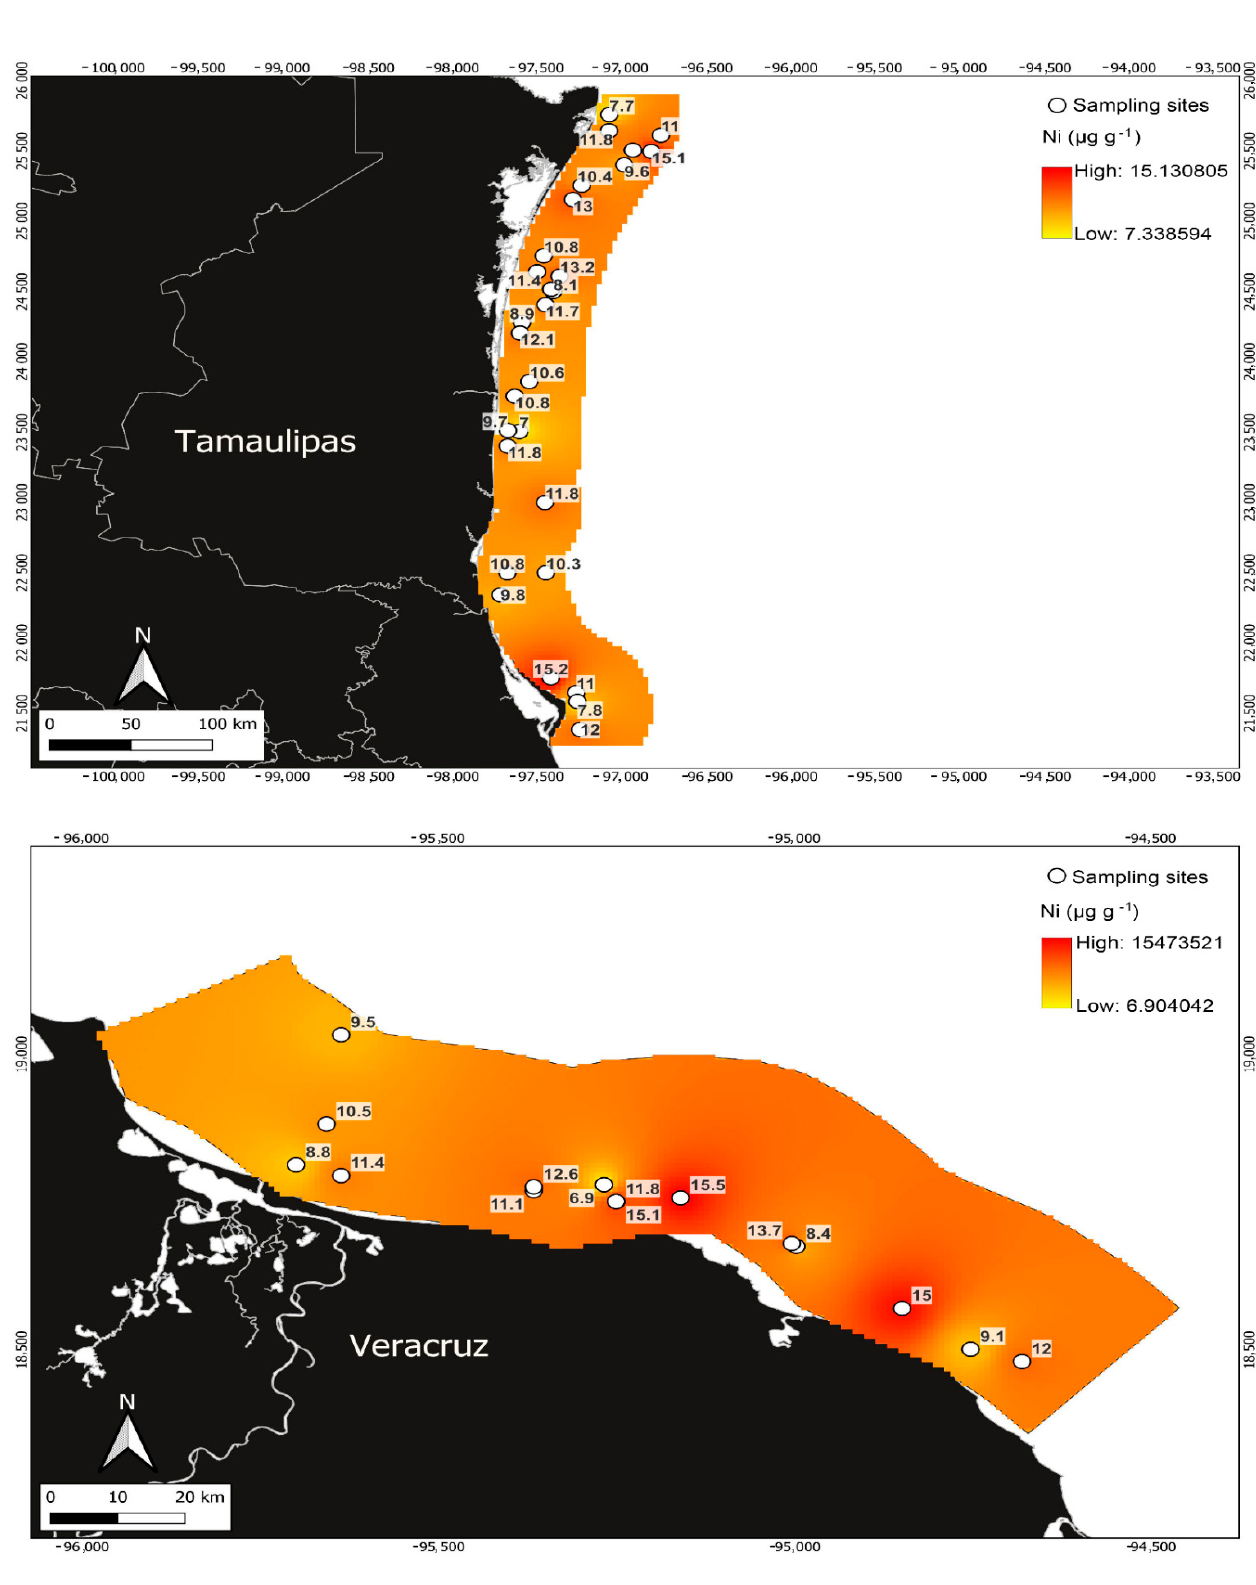
Figure 5. Ni concentrations in Penaeus aztecus shrimp (whole body) in the areas of Tamaulipas ( upper ) and Veracruz ( below ), Mexico.